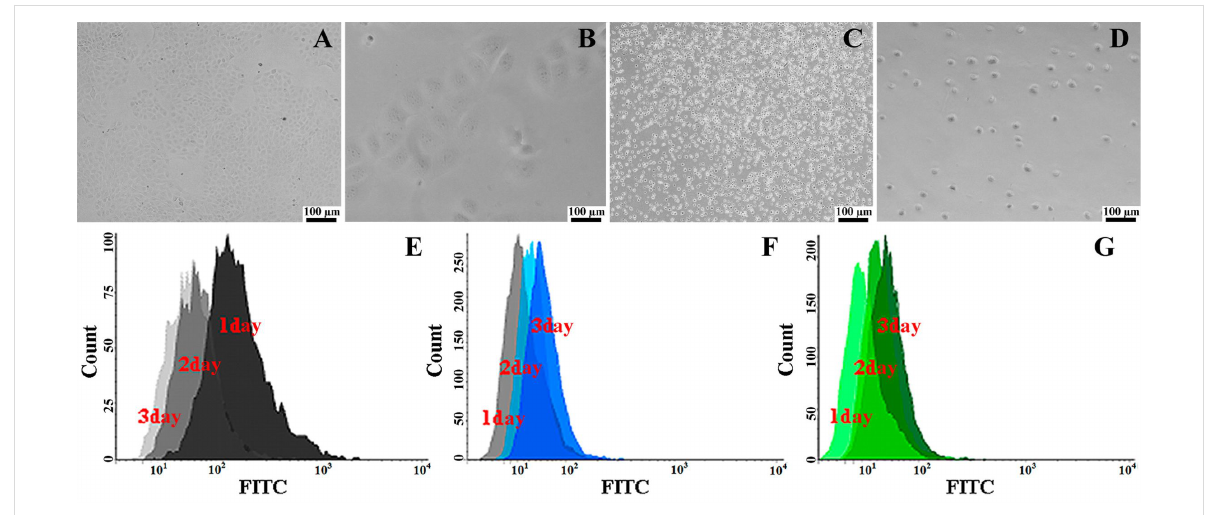
Figure 3: Optical microscopy images demonstrating the cultivation for 24 h of (A, B) substrate-attached intact HeLa cells and (C, D) HeLa cells coated with halloysite-doped silica shells; flow cytometry monitoring of cell division for three days of CFSE-stained (E) intact HeLa cells, (F) silica- coated HeLa cells and (G) HeLa cells coated with halloysite-doped silica